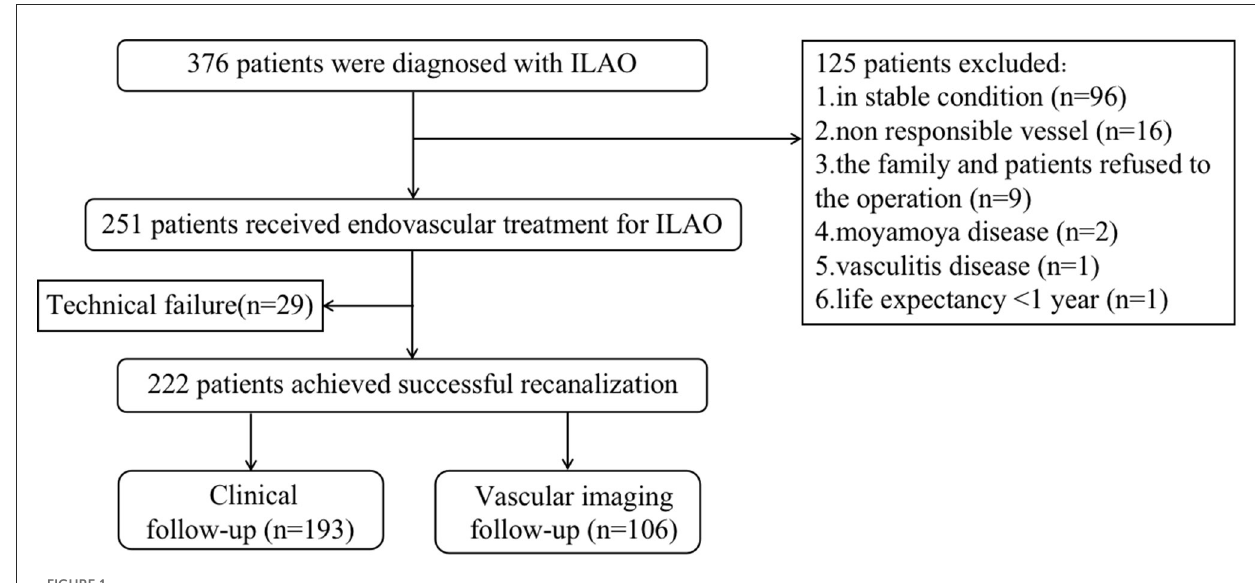
FIGURE1 Flowchart of the study. ILAO, intracranial large artery